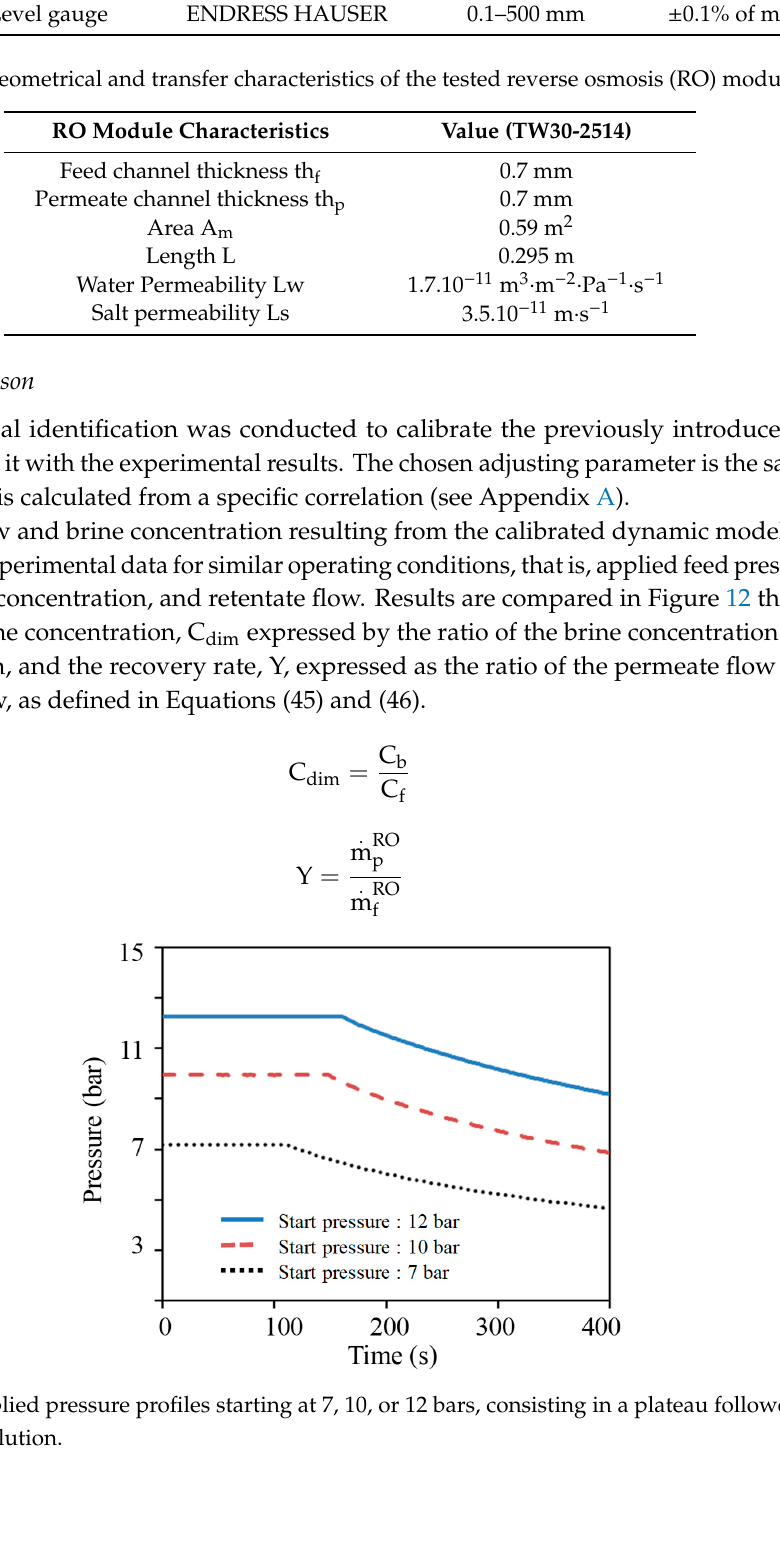
Table 2. Geometrical and transfer characteristics of the tested reverse osmosis (RO) module.